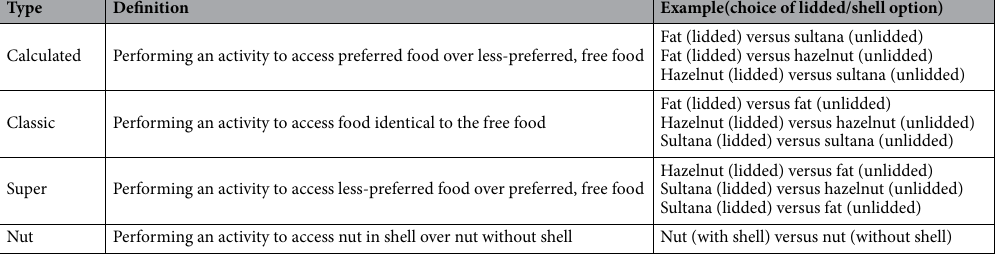
Table 1. Contrafreeloading type definitions with